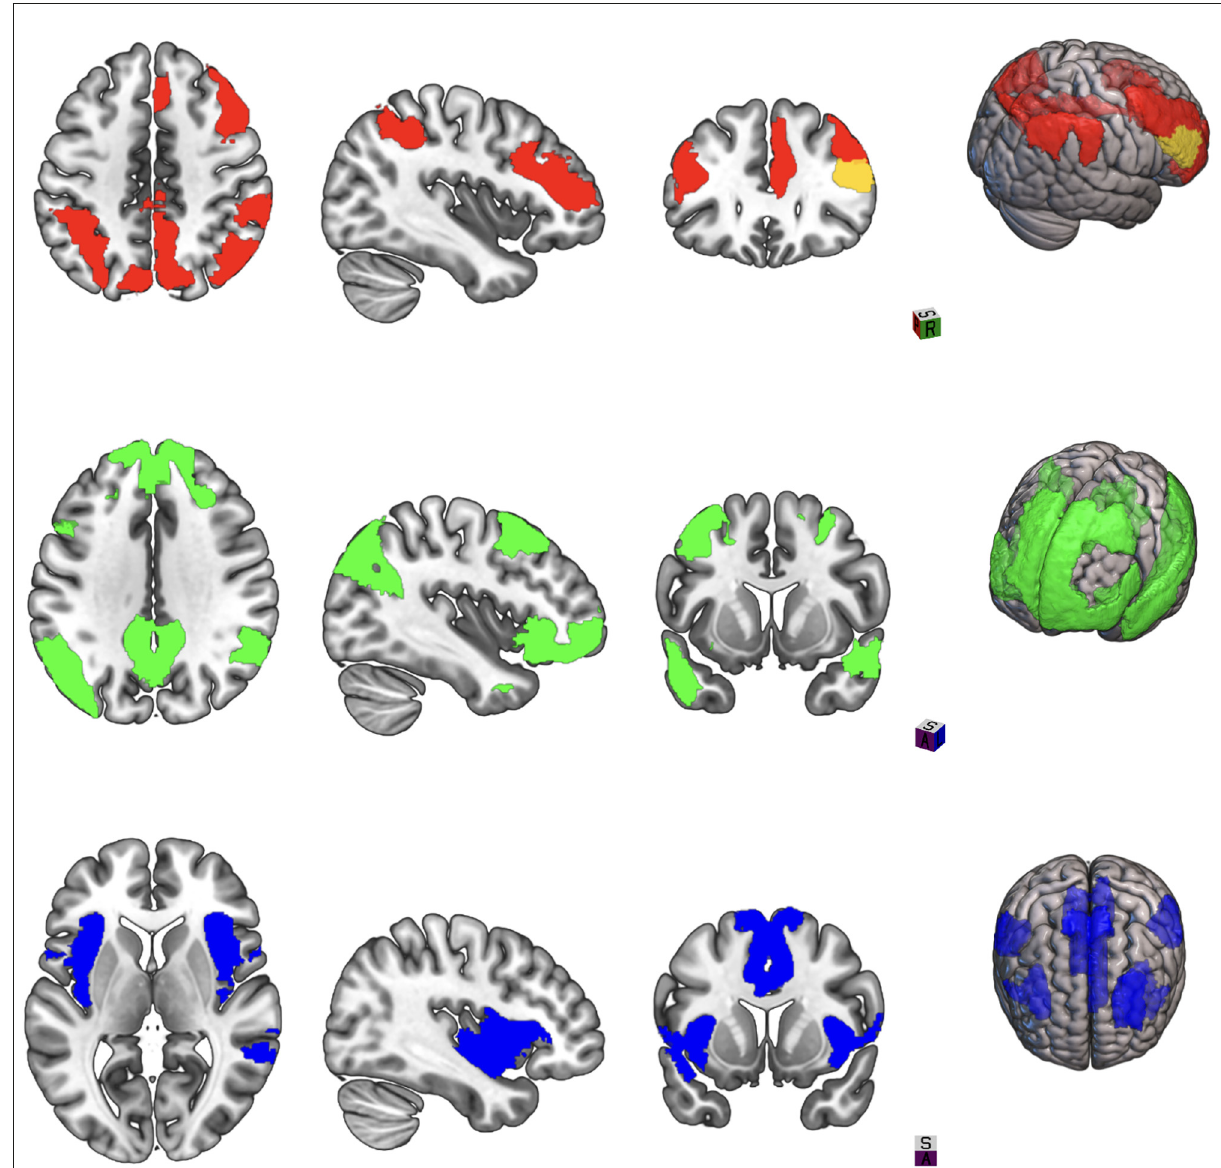
FIGURE1 Three large-scale brain networks implicated in neuropsychiatric disorders. Areas in color represent brain regions designed as network nodes in the Yeo atlas. Top : Central executive network. Middle : Default mode network. Bottom : Salience